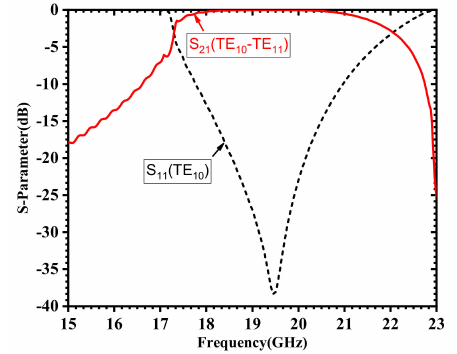
Figure 6. Geometric structure of the Y-type input coupler.